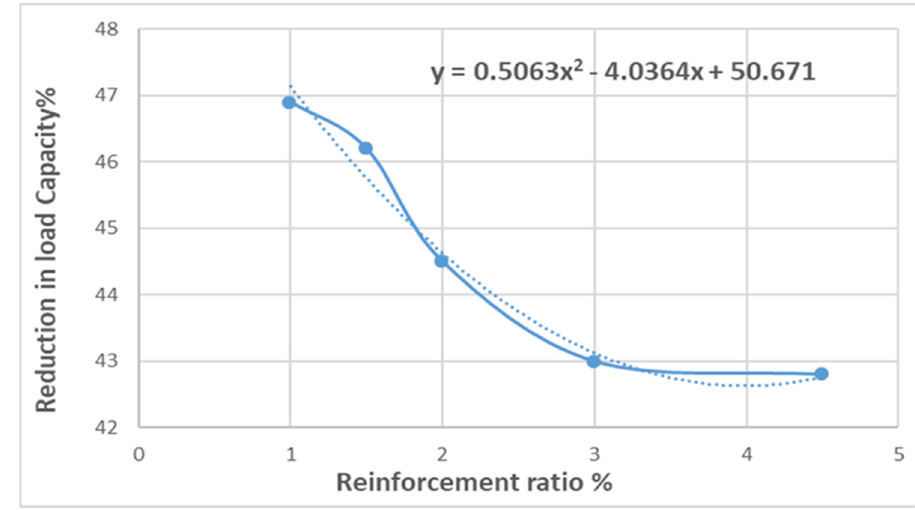
Figure 6: Reduction in load capacity – reinforcement ratio relationship.